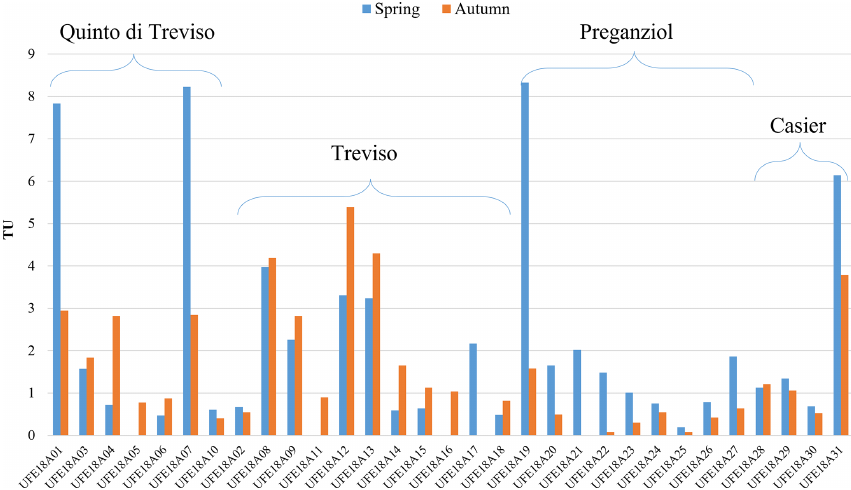
Figure 8. Tritium data comparison between the two different campaigns in the same sampling